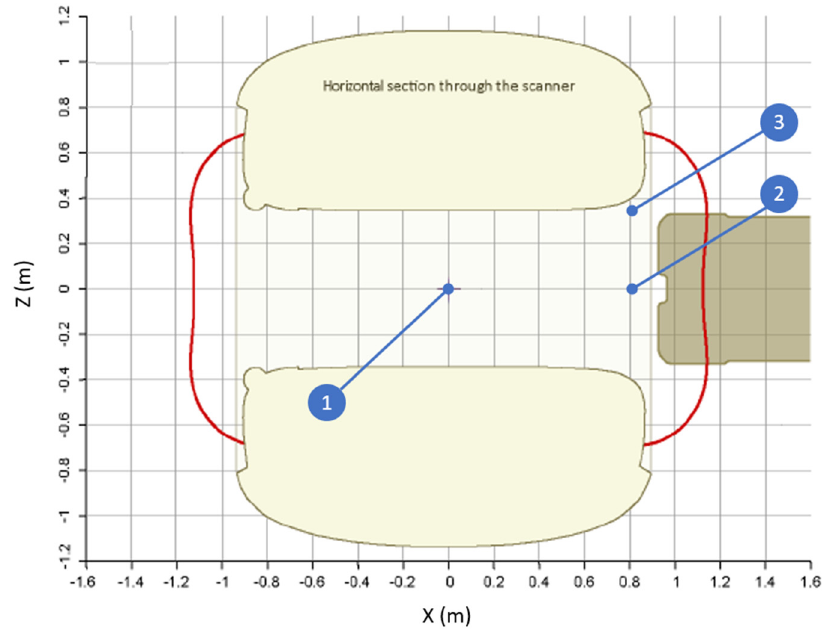
Figure 6. Schematic overview of the test positions in the scanner: (1) isocenter; (2) edge of the bore along the scanner axis; and (3) edge of the scanner bore and at the edge of the patient bed. Figure adapted from Philips Ingenia Technical Description (Philips Healthcare, Best, NL).